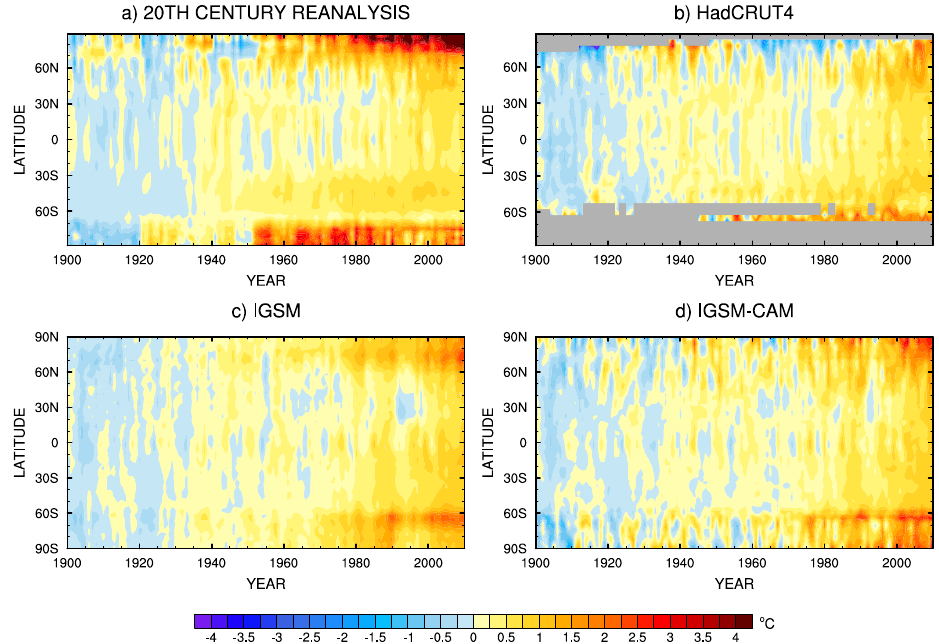
Fig. 9. Hovmöller diagrams of zonal-mean surface air temperature anomalies from the 1901–1950 mean ( ◦ C) for the IGSM and IGSM-CAM simulations, under median climate sensitivity, and for the HadCRUT4 and 20CR